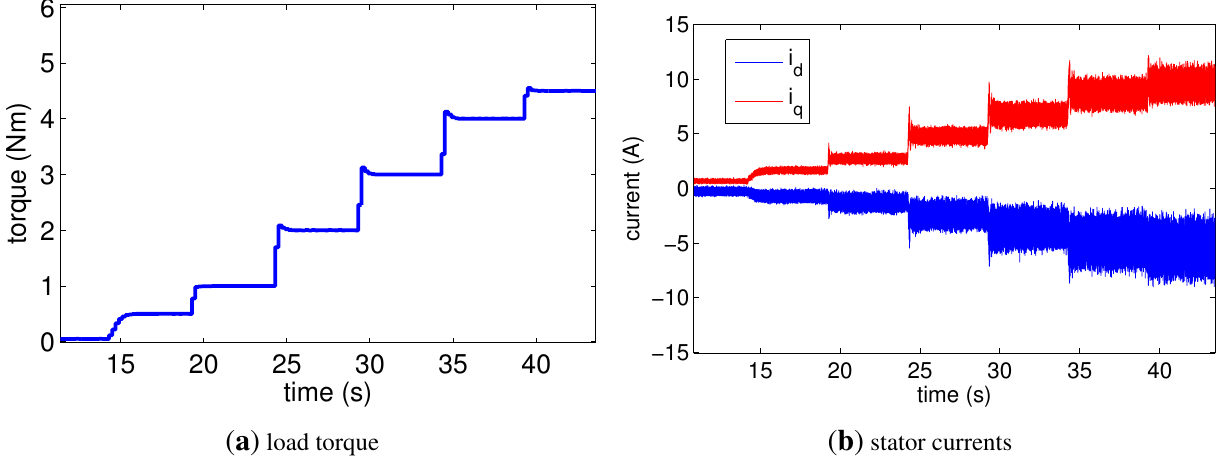
Figure 5. ( a ) Plan of load torque used in the experiment; ( b ) Stator currents in healthy motor under the